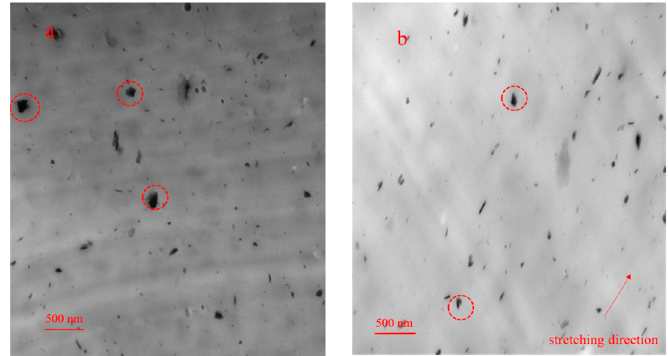
Figure 1. The TEM graphs of PA510/SiO 2 films at the stretching ratio of ( a ) 1 × 1 and ( b ) 1 × 3.